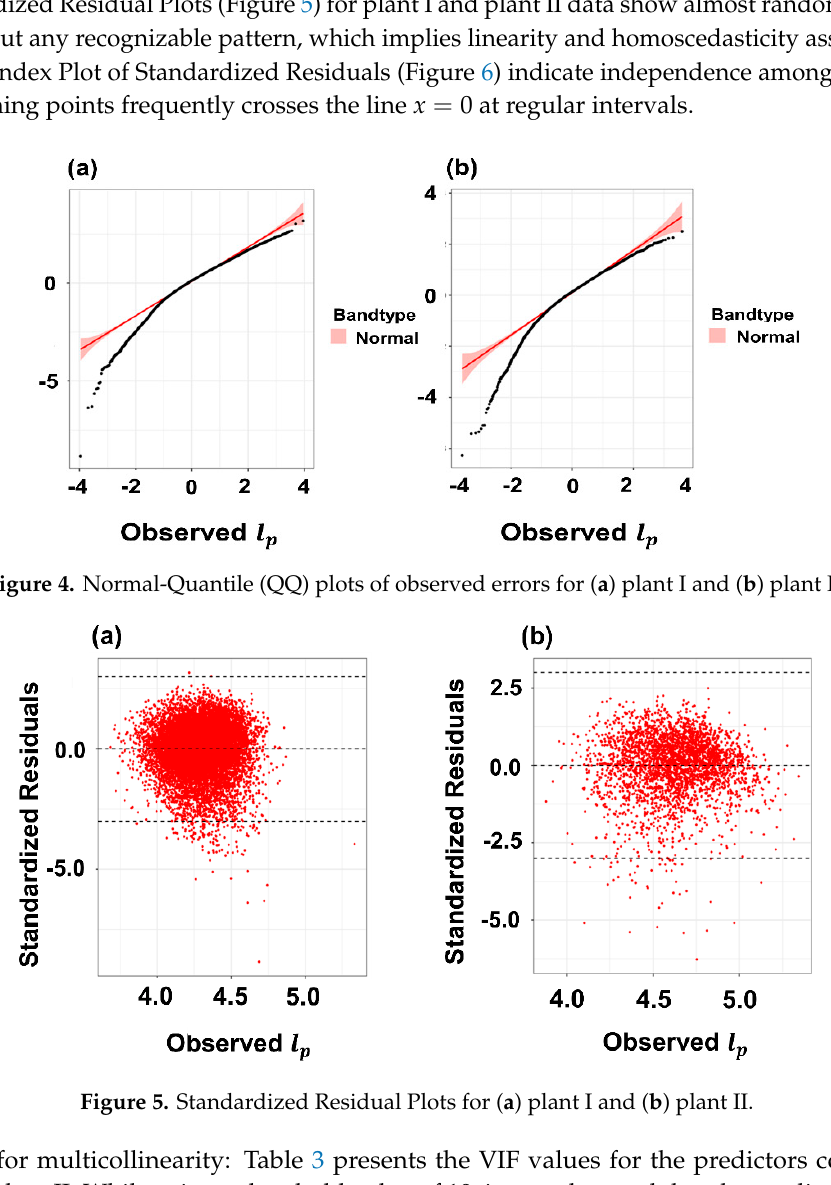
Figure 4. Normal-Quantile (QQ) plots of observed errors for ( a ) plant I and ( b ) plant II.